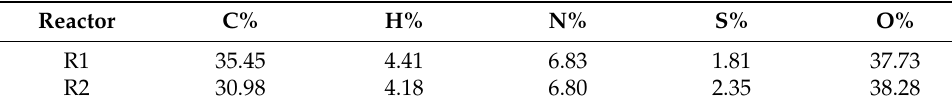
Table 2. Elemental analysis of aerobic granular sludge.